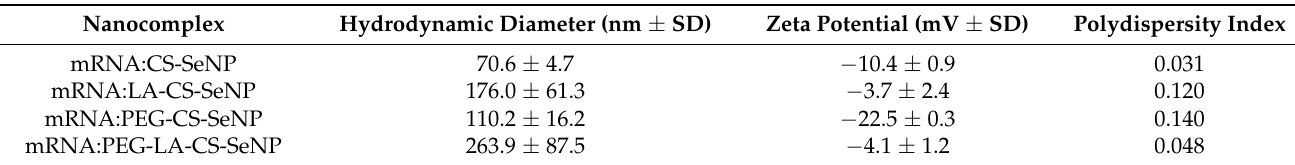
Table 2. Hydrodynamic size distribution, zeta potential, and polydispersity of mRNA:SeNP nanocomplexes at their optimal binding mRNA:NP w/w ratios: (CS-SeNPs (1:5), LA-CS-SeNPs (1:6), PEG-CS-SeNPs (1:5), and LA-PEG-CS-SeNPs